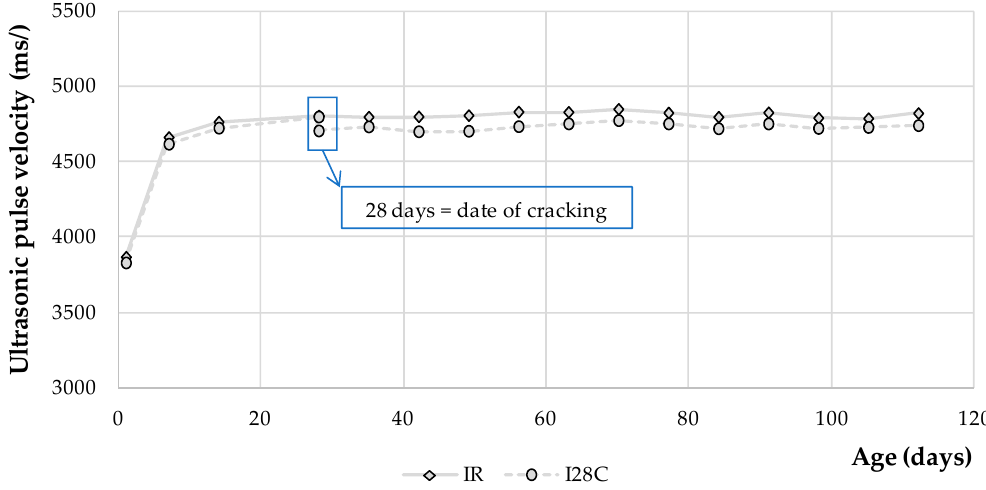
Figure 2. Ultrasonic pulse velocity of uncracked concrete (IR) and 28 day cracked concrete (I28C) with CEM I.